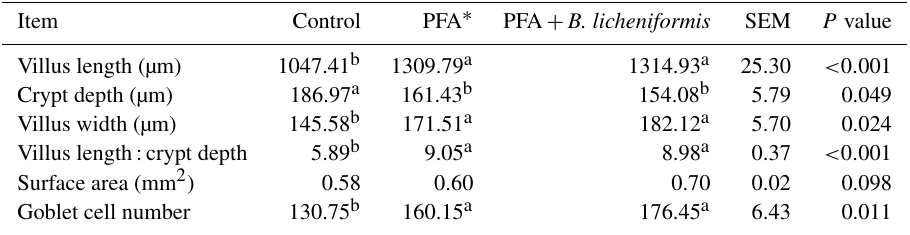
Table 6. Jejunal histomorphometry of broiler chickens fed supplemental phytogenic feed additive alone or in combination with Bacillus licheniformis .